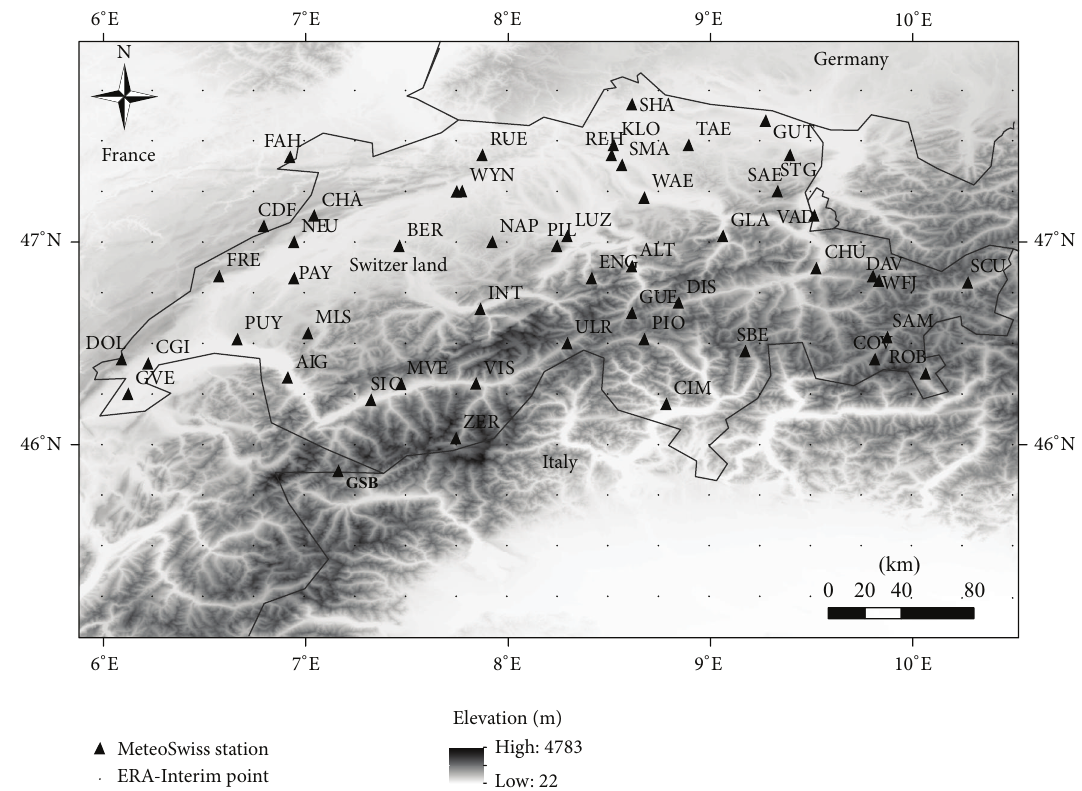
Figure 1: Location of the MeteoSwiss sites (triangles) and ERA-Interim 0.25 ∘ × 0.25 ∘ points (dots). The elevation ranges from 22 to 4783 m a.s.l., with a DEM resolution of 90